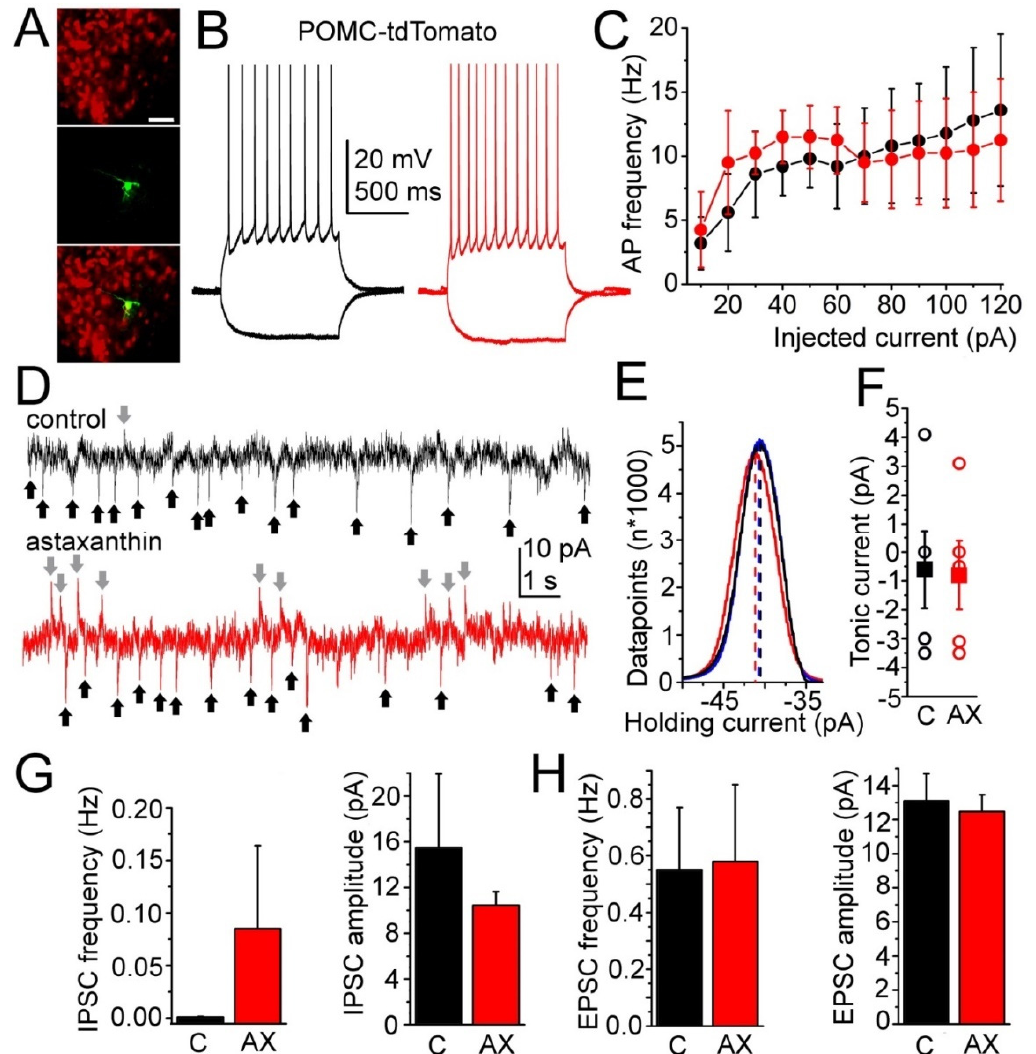
Figure 4. Changes by acute astaxanthin feeding on POMC-positive neurons of the arcuate nucleus. ( A ) Evaluation of the neuronal type. Upper panel: POMC-driven tdTomato expression in red. Middle panel: biocytin labeling (green). Lower panel: merged image. Images represent a single confocal z-stack with 1- µ m thickness. Scale bar: 50 µ m; ( B ) voltage traces from a POMC-positive neuron under control conditions (black) and with acute 2.5 µ M AX treatment (red) elicited with − 30 and +120 pA current injections; ( C ) comparison of the average firing rate with different depolarizing steps under control conditions and during AX application (red); ( D ) synaptic currents of a POMC-positive neuron under control conditions (above) and during AX treatment (below). Black arrows: EPSCs, gray arrows: IPSCs; ( E ) a representative trace of histogram analysis of the holding current under control (black) and in the presence of astaxanthin (red); ( F ) statistical comparison of the spontaneous fluctuation of the holding current (C, black) and the effect of astaxanthin on the holding current (AX, red; hollow circles: individual data, filled squares: average ± SEM); ( G , H ) statistical analysis of the IPSC ( G ) and EPSC ( H ) frequency and amplitude. Black columns: control conditions (C), red columns: astaxanthin treatment